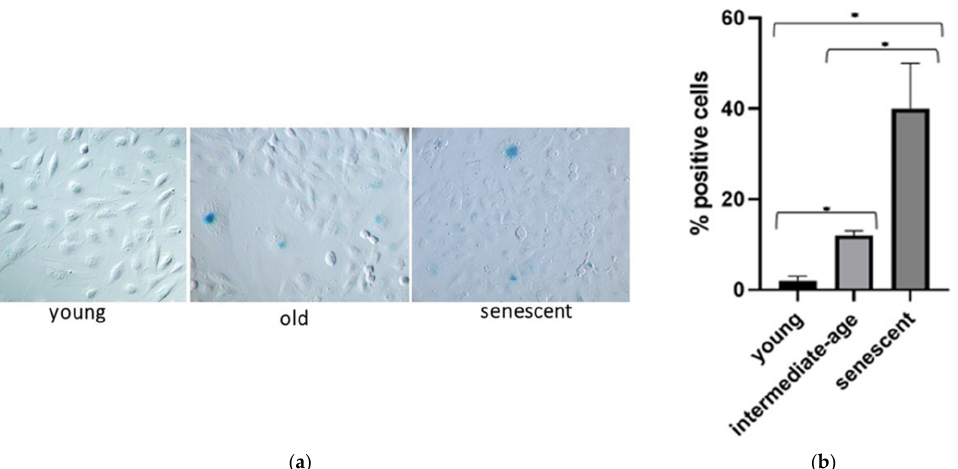
Figure 5. Human umbilical vein endothelial cells (HUVECs) senescence status. Senescence status was estimated by SA- β -Gal assay in different passage numbers; images are representative of three independent experiments ( a ). Replicative senescence. Data are expressed as % of SA- β -Gal positive cells and are the means ± SD ( b ). Comparison among multiple groups was analyzed by one-way analysis of variance, followed by Bonferroni’s post hoc test. * p < 0.01.